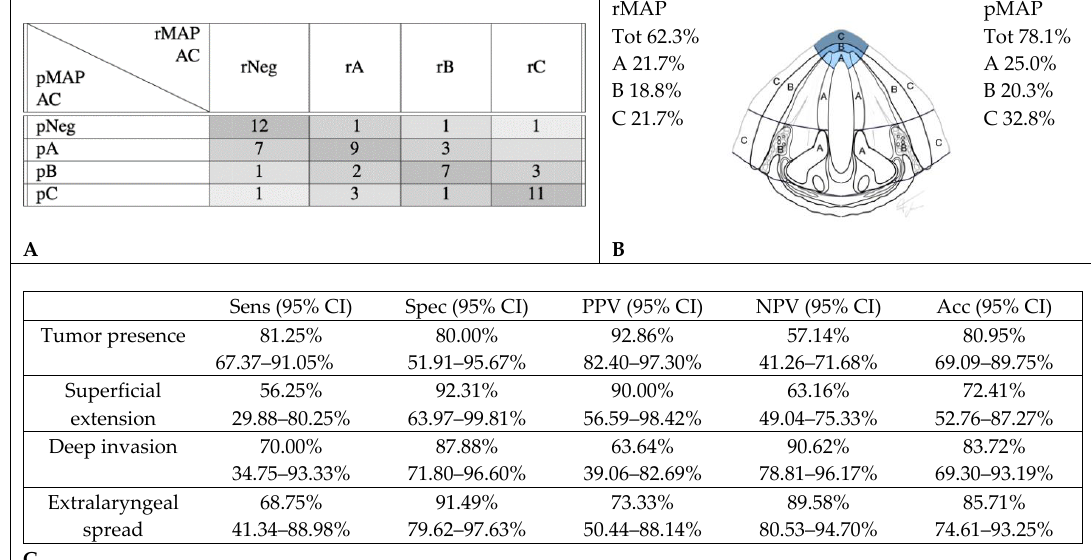
Figure 2. Accuracy in the radiological assessment of anterior commissure (AC) involvement. ( A ) Graphical representation of concordance between CT and histopathology in anterior commissure assessment. ( B ) Percentage of cancer involvement of anterior commissure in rMAP and pMAP. ( C ) Sensitivity (Sens), specificity (Spec), positive predictive value (PPV), negative predictive value (NPV) and accuracy (Acc) of CT in anterior commissure. CI: confidence interval, rMAP: radiological glottic map and pMAP: histopathological glottic map.